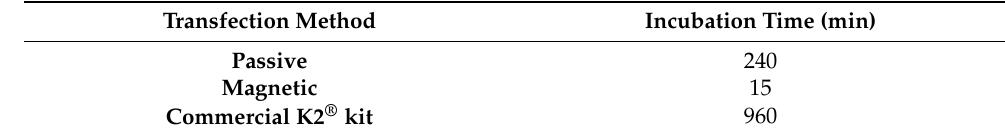
Table 2. Incubation times comparison of different transfection